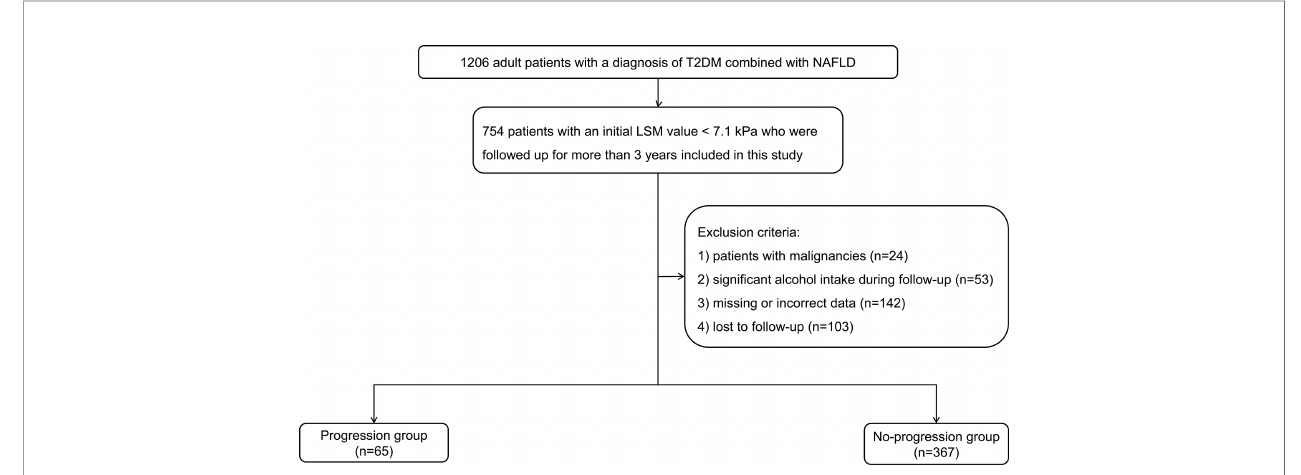
FIGURE 1 | Flowchart of patient selection and grouping. T2DM, type 2 diabetes mellitus; NAFLD, non-alcoholic fatty liver disease; LSM, liver stiffness